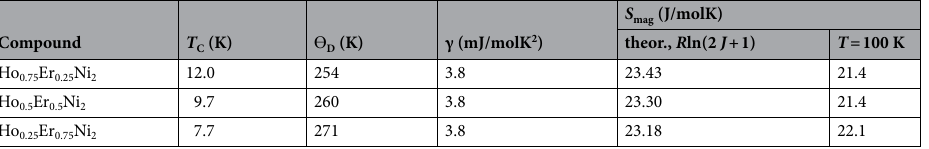
Table 1. Curie temperature T C , low-temperature limit of Debye temperature, Sommerfeld coefficient γ and maximum magnetic entropy determined theoretically (calculated) and experimentally at a temperature of 100 K for the investigated Ho 1-x Er x Ni 2 intermetallic compounds determined from the heat capacity measurements. The characteristic temperatures were determined to an accuracy of ± 0.1 K. The magnetic entropy was calculated to an accuracy of ± 0.1 J/molK.